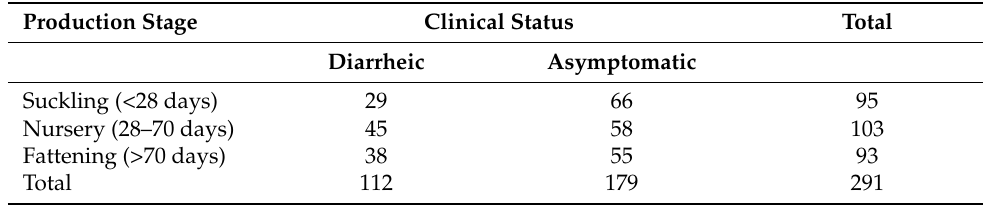
Table 1. Fecal samples